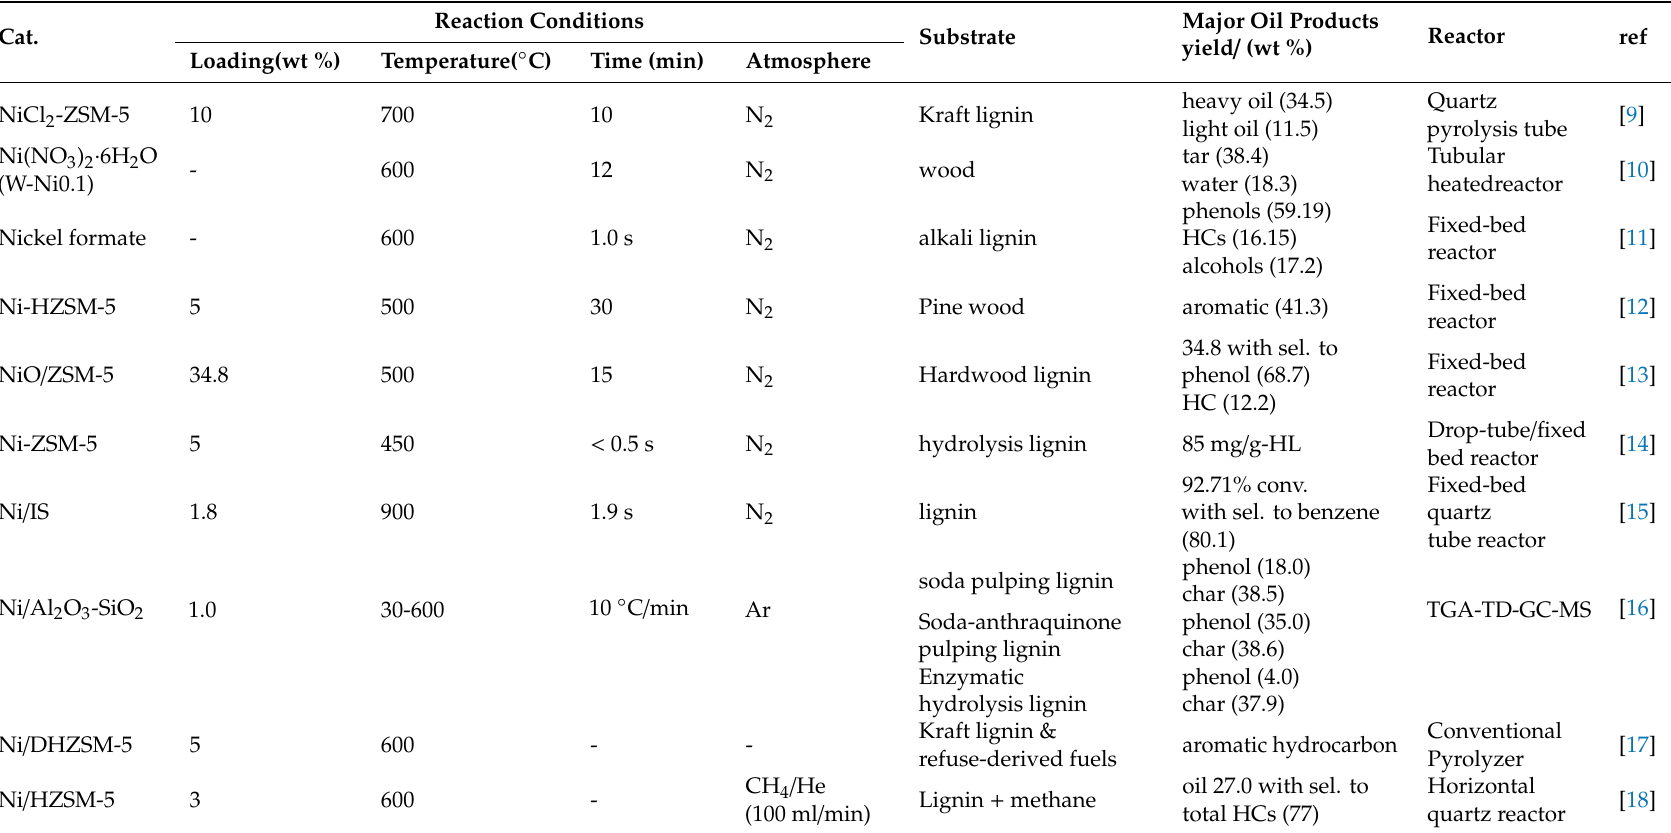
Table 1. Pyrolysis of lignin to oil over Ni-based